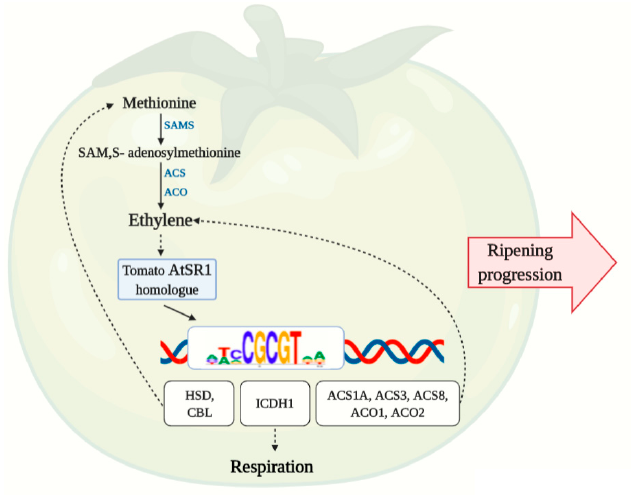
Figure 8. A proposed scheme for the synchronized regulation of fruit respiration and ethylene production during MG pre-climacteric stage by the tomato AtSR1 homologue. SAMS, S-adenosyl- methionine synthase; ACS, ACC synthase; ACO, ACC oxidase; HSD, homoserine dehydrogenase;